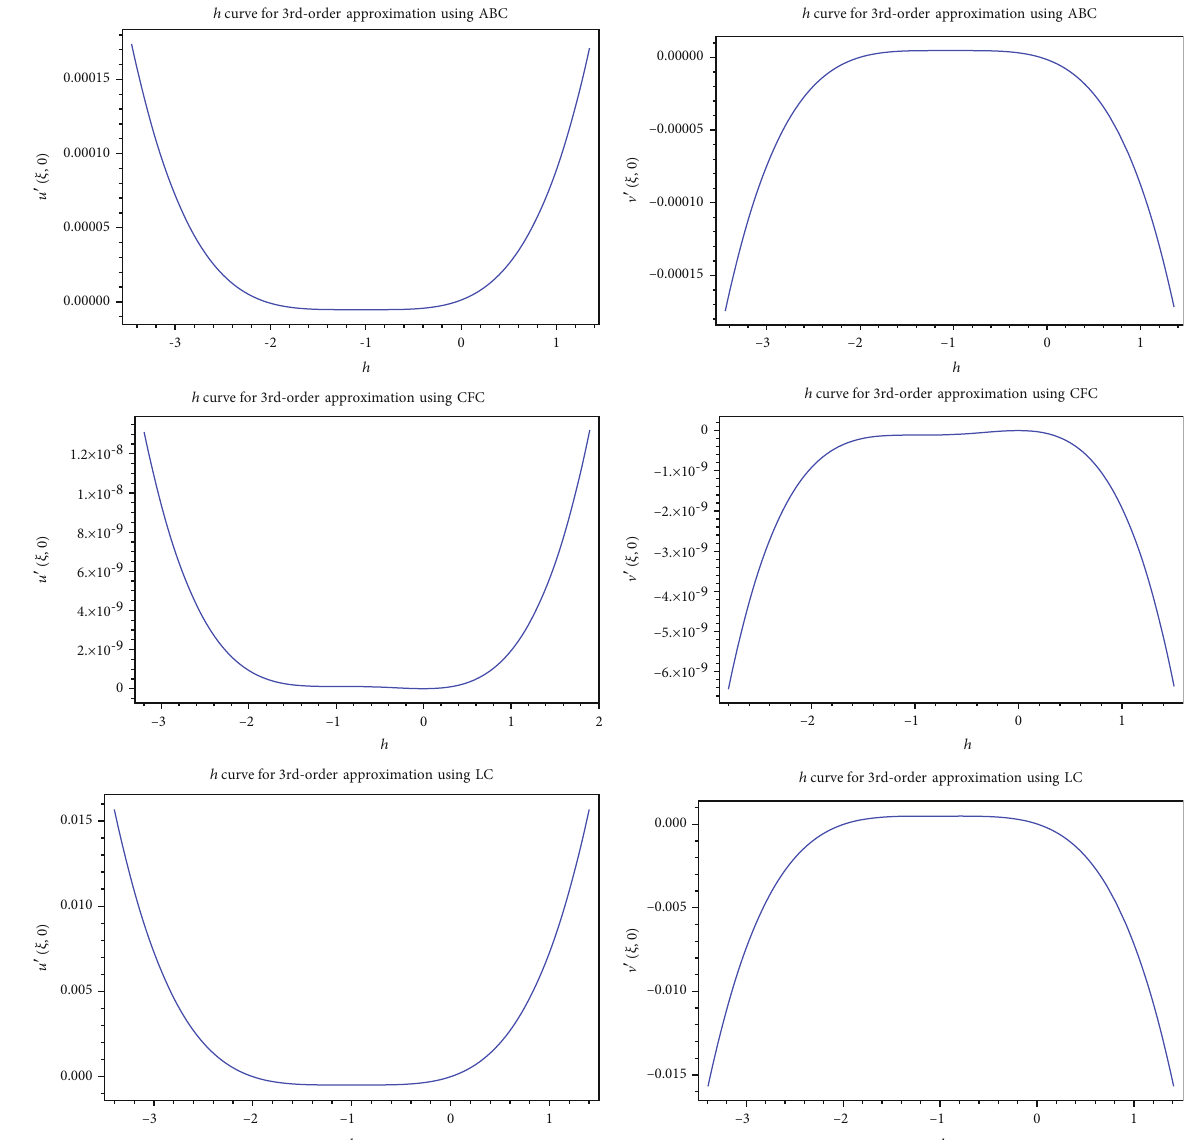
δ and η tend to 1 and